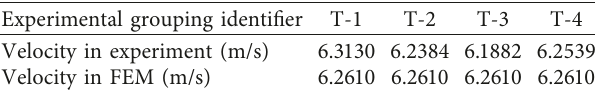
Table 3: The instantaneous impact velocity of the hammer